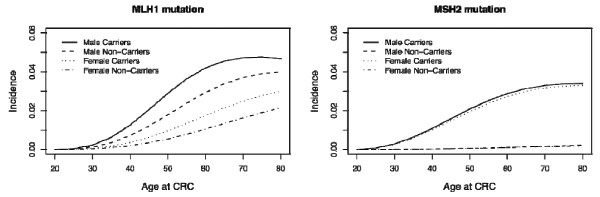
Gender-specific and/or mutation-specific hazard rate estimates of developing colorectal cancer (CRC) in MLH1 gene (left) and MSH2 gene (right) mutations, based on the segregation analysis.